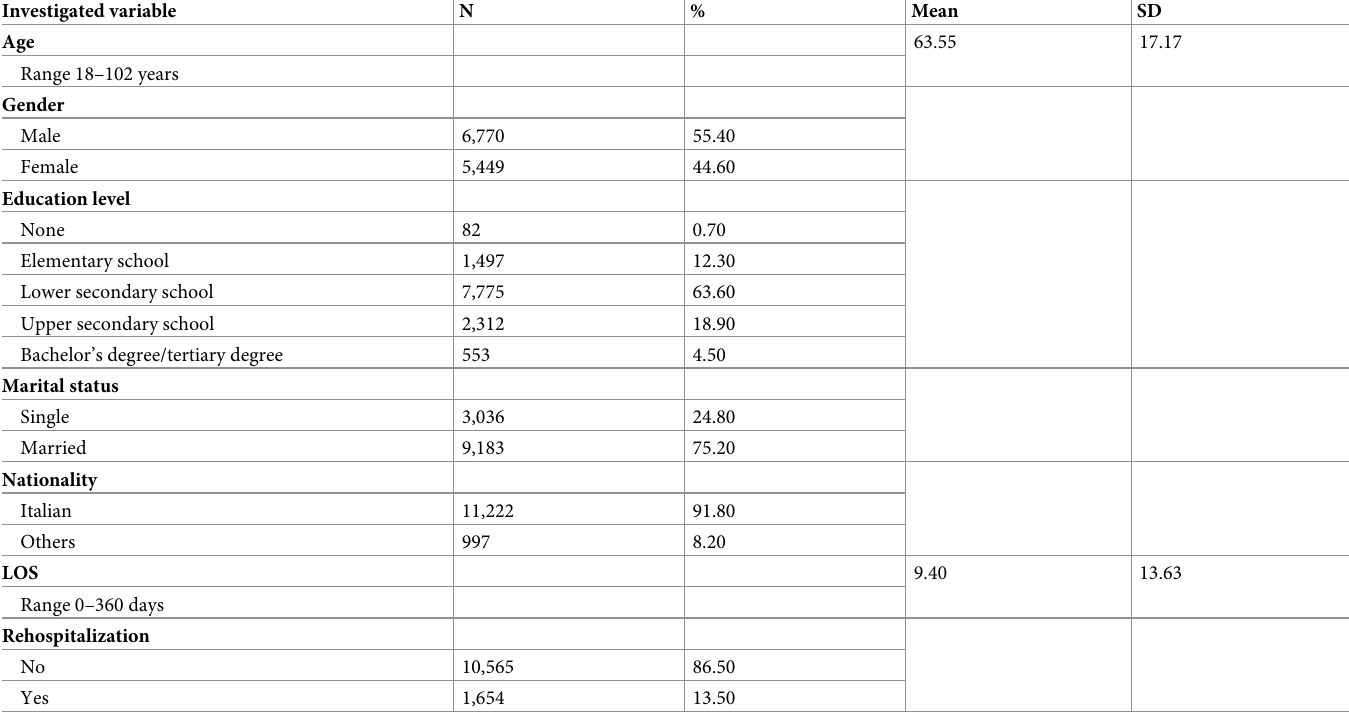
Table 4 lists the frequency of infections per site. Sociodemographic and outcome variables were analyzed for the eight microorganisms under investigation and are presented in Table 5. Table 1. Descriptive analysis of the samples (n =